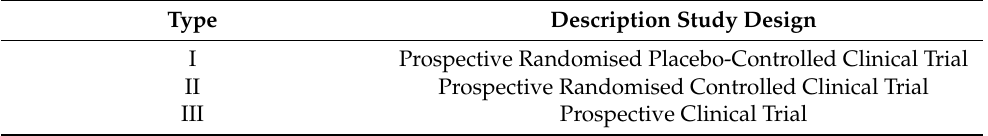
Table 1. Records were categorised according to the scientific study